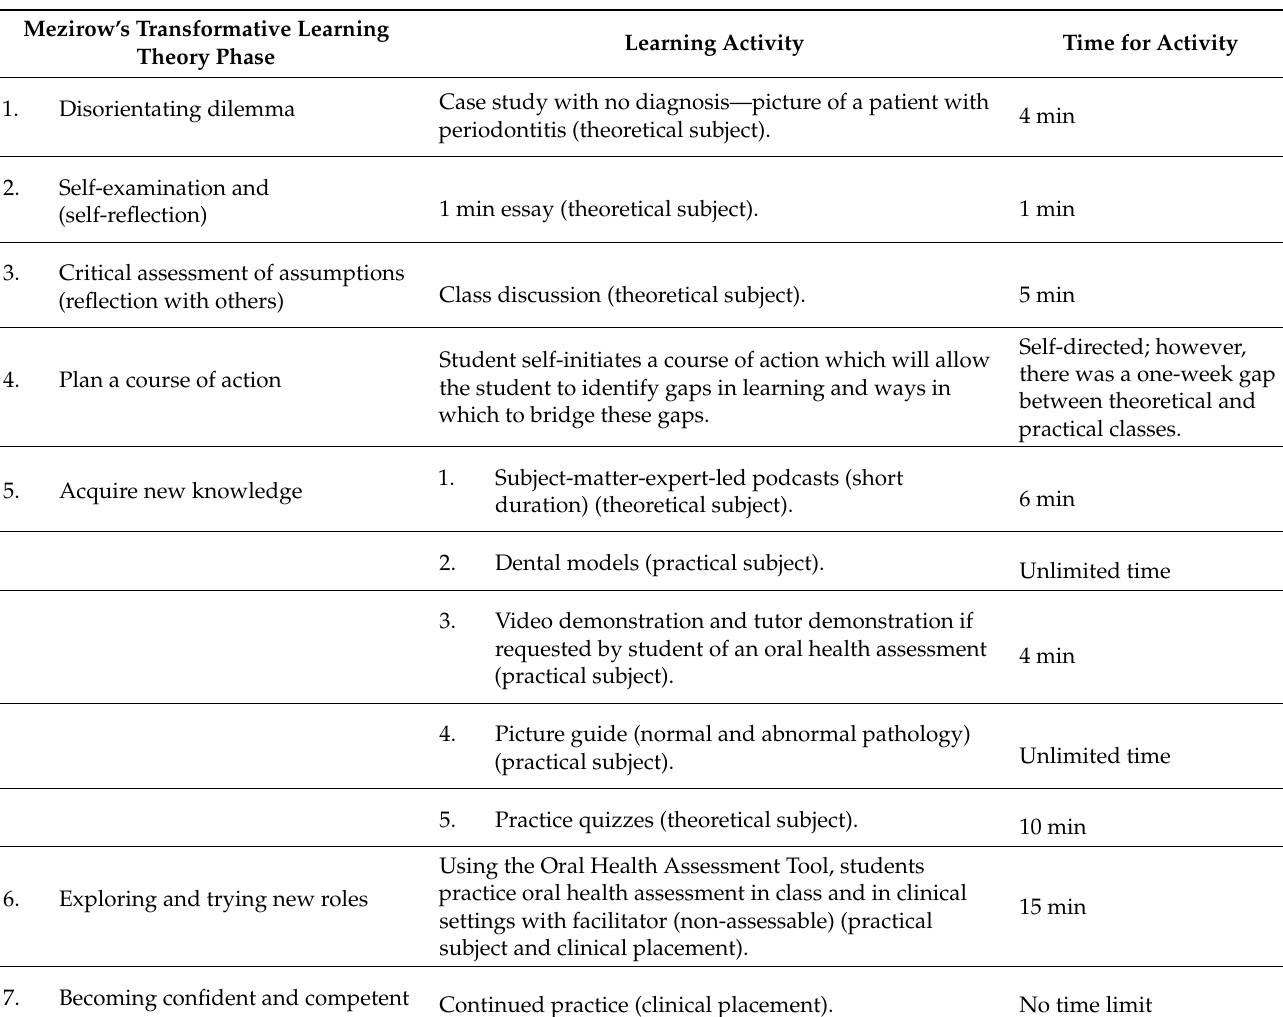
Table 1. Final codesigned learning